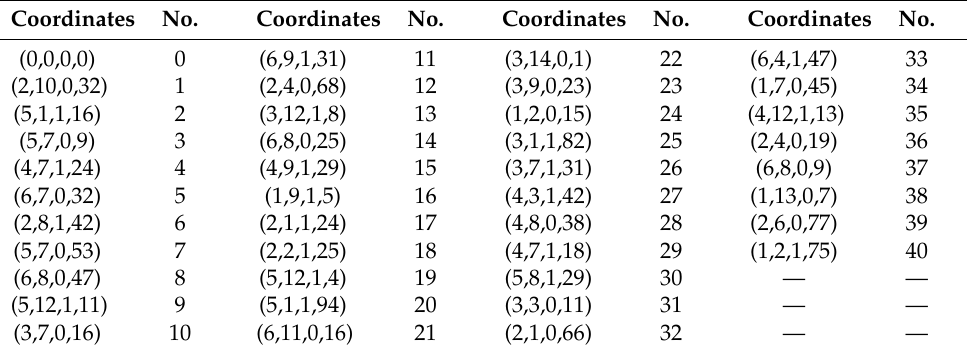
Table 8. Coordinates and number when the number of locations to be visited is 40.